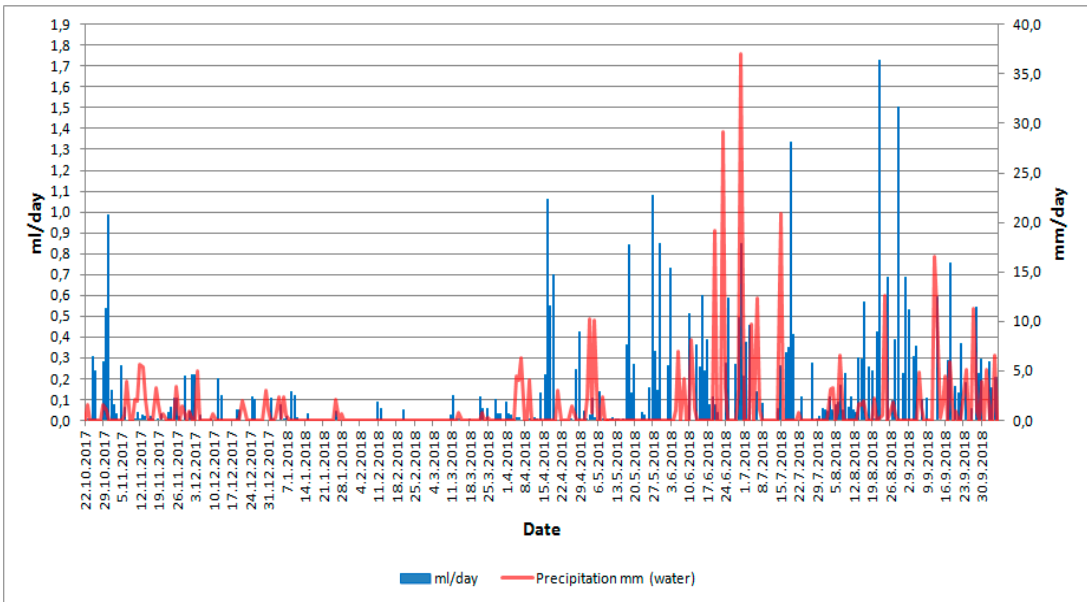
Figure 6. Daily sedimentation flux rate from Savilahti from 22 October 2017 to 6 October 2018. Bar diagram shows sedimentation flux rate in mL / day and line diagram shows water precipitation in mm / day (red line) during the investigation period. Table 2. Descriptive statistics of variables used in study.